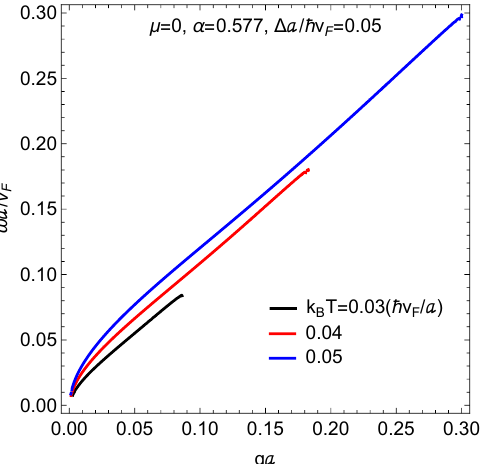
Figure 5. Frequency versus wave number of the temperature-induced magnetoplasmons in an α – T 3 model in low magnetic field. Three different temperatures are chosen. The hopping and mass term parameters are